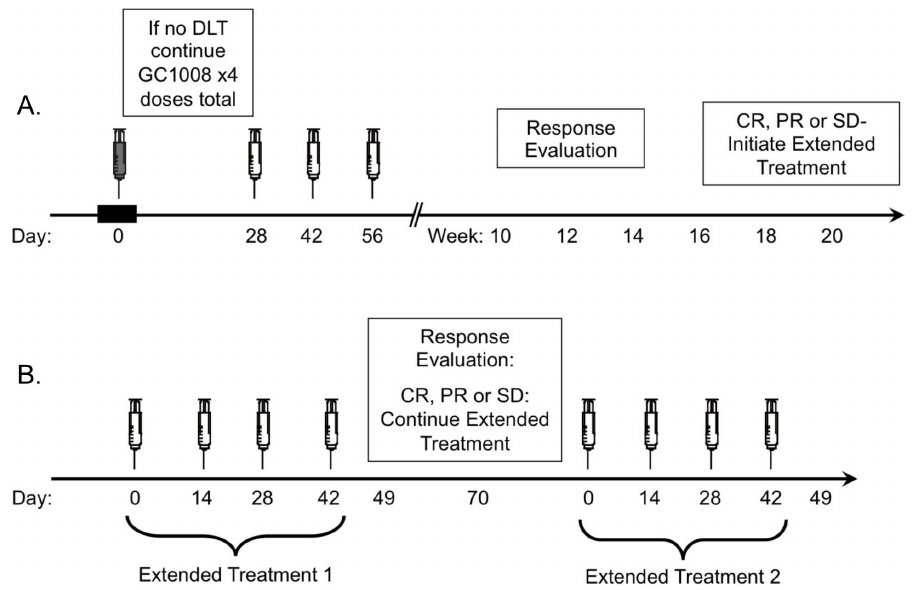
Figure 2. Trial Design. A . GC1008 treatment and dose-escalation schema. Groups of 3 to 6 subjects received an initial dose of GC1008 and were monitored for 28 days for DLT. Subjects experiencing no DLT received three additional doses of GC1008 every 2 weeks. Subjects underwent assessment of tumor response week 12 that was confirmed at least 4 weeks later. B . Extended Treatment schema. Subjects who achieved a response of stable disease or better were eligible for Extended Treatment at the current dose of GC1008 determined to be safe which was administered every 2 weeks 6 4 doses. Up to two cycles of Extended Treatment could be given as long as the response was maintained.